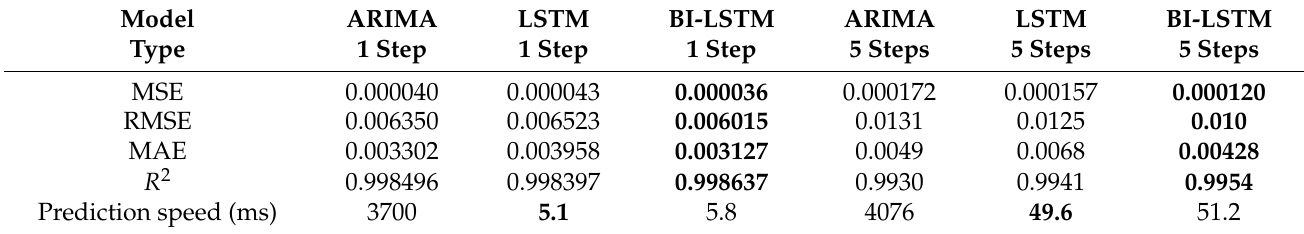
Table 5. Experiment result on FIFA Worldcup 98 dataset.